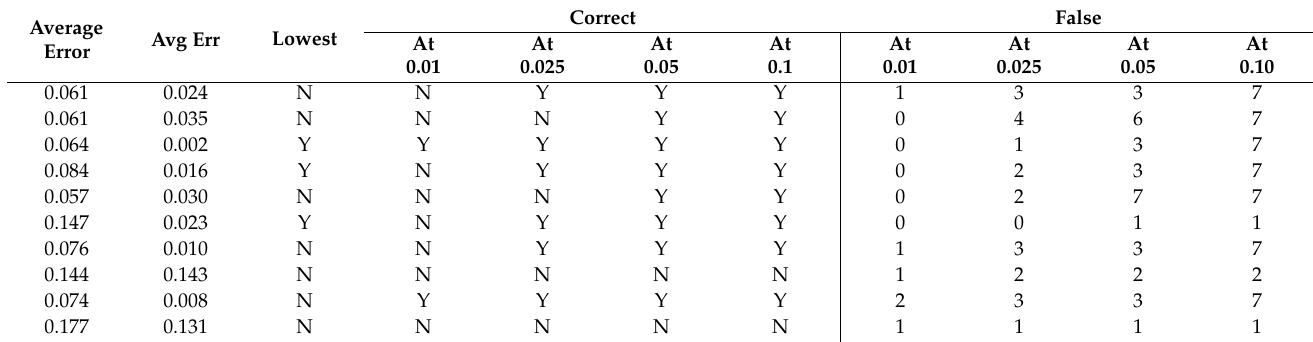
Table A62. Set 1, trials 31–40 summary data (average actual PR values).